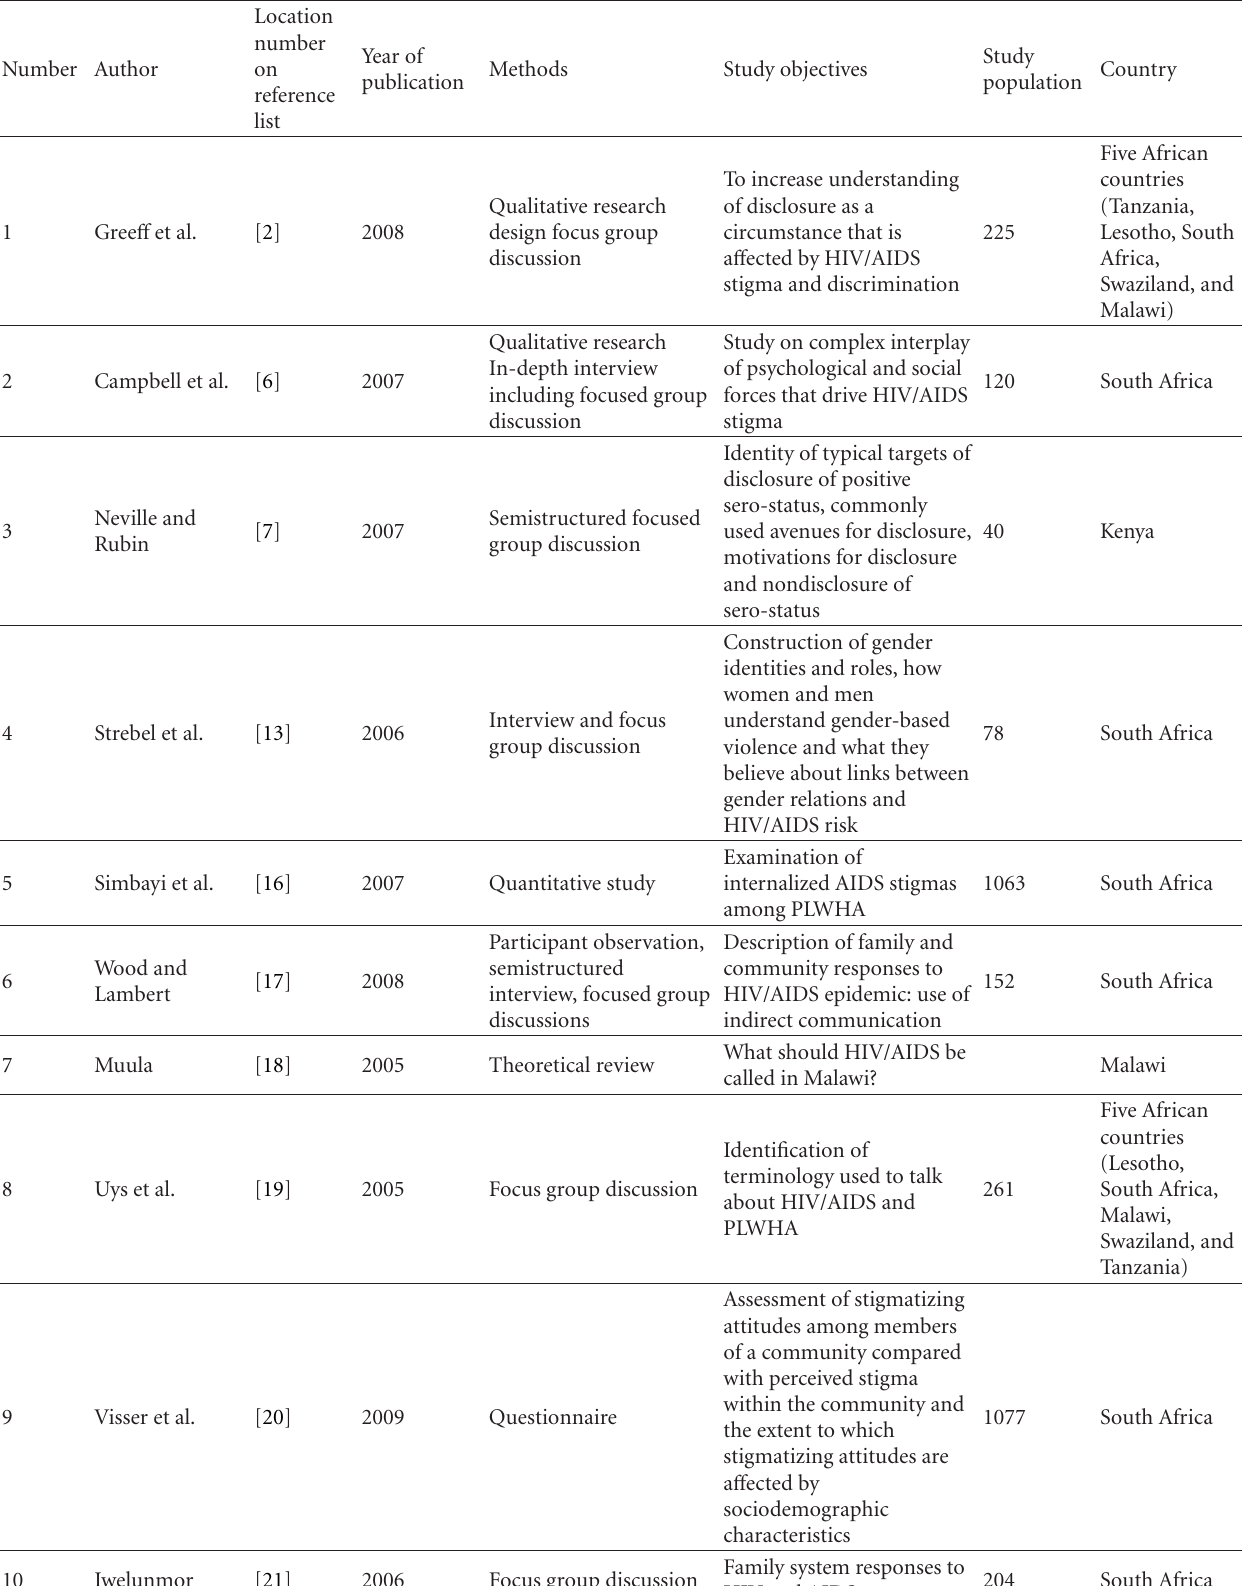
Table 1: Characteristics of the empirical studies